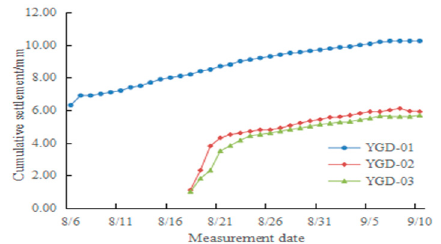
Figure 10. Relation between crown settlement and time.